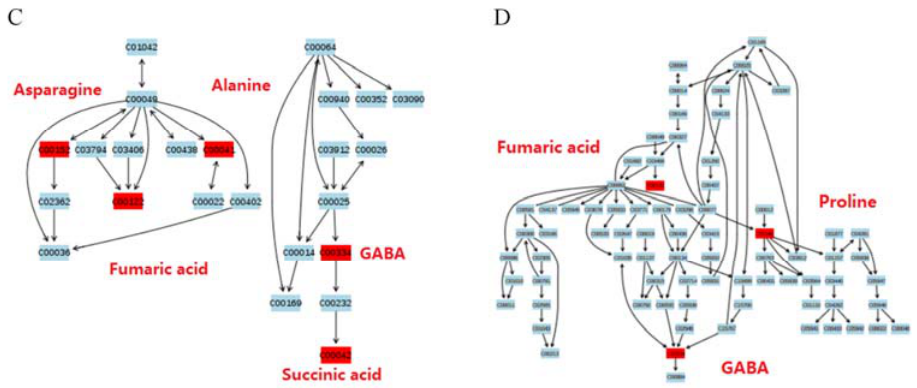
Figure 5. ( A ) Correlation analysis of 11 metabolites from mulberry leaves extracts; ( B ) Overview of pathway analysis with 11 metabolites from mulberry leaves extracts; ( C ) Alanine, aspartate and glutamate metabolism; ( D ) Arginine and proline metabolism.